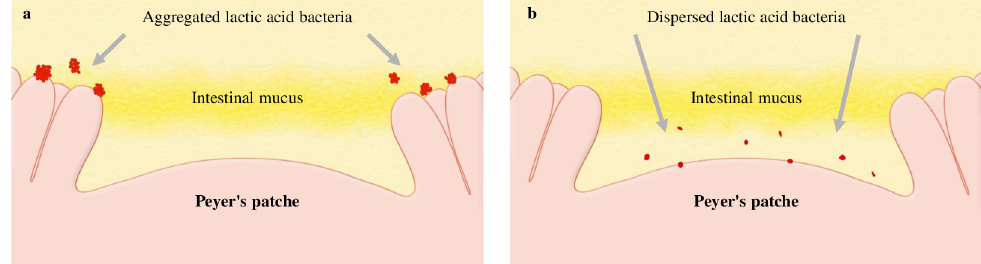
Fig 8. Image of n-LAB or d-LAB in contact with the small intestinal Peyer’s patches. n-LAB could not reach the Peyer’s patches because of large particle size, which is blocked by mucus (a). d-LAB were small particle size and can pass via mucus to reach the Peyer’s patches (b). d-LAB, dispersed lactic acid bacteria; n-LAB, non-treated lactic acid bacteria.